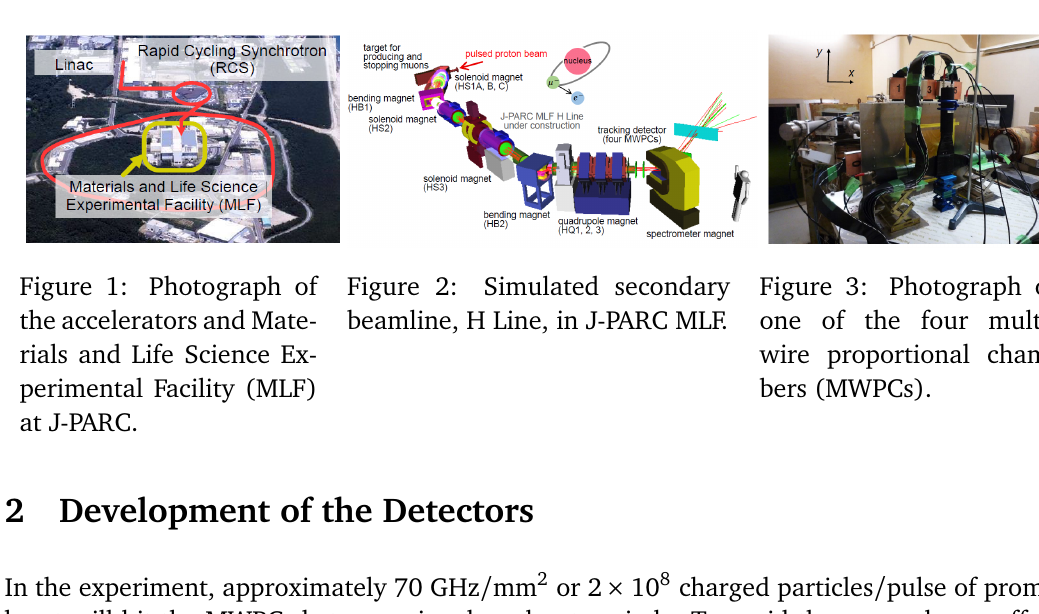
Figure 2: Simulated secondary beamline, H Line, in J-PARC MLF.